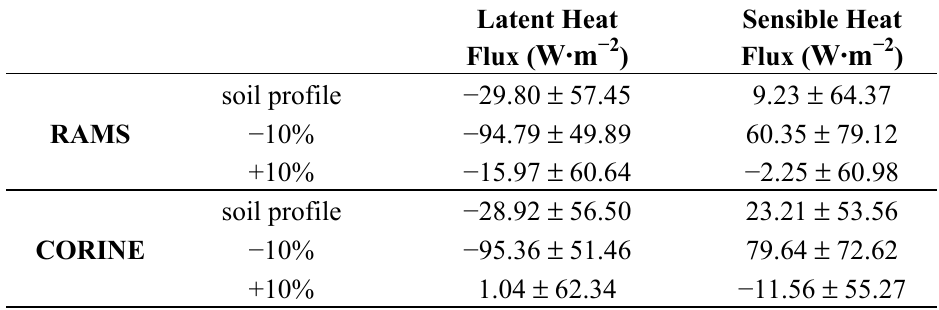
Table 5. Mean and standard deviation of the differences between area-averaged aircraft measured values and simulated ones from Figure